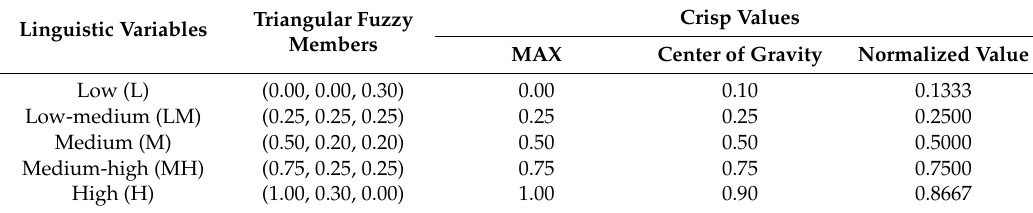
Table 5. Defuzzied linguistic